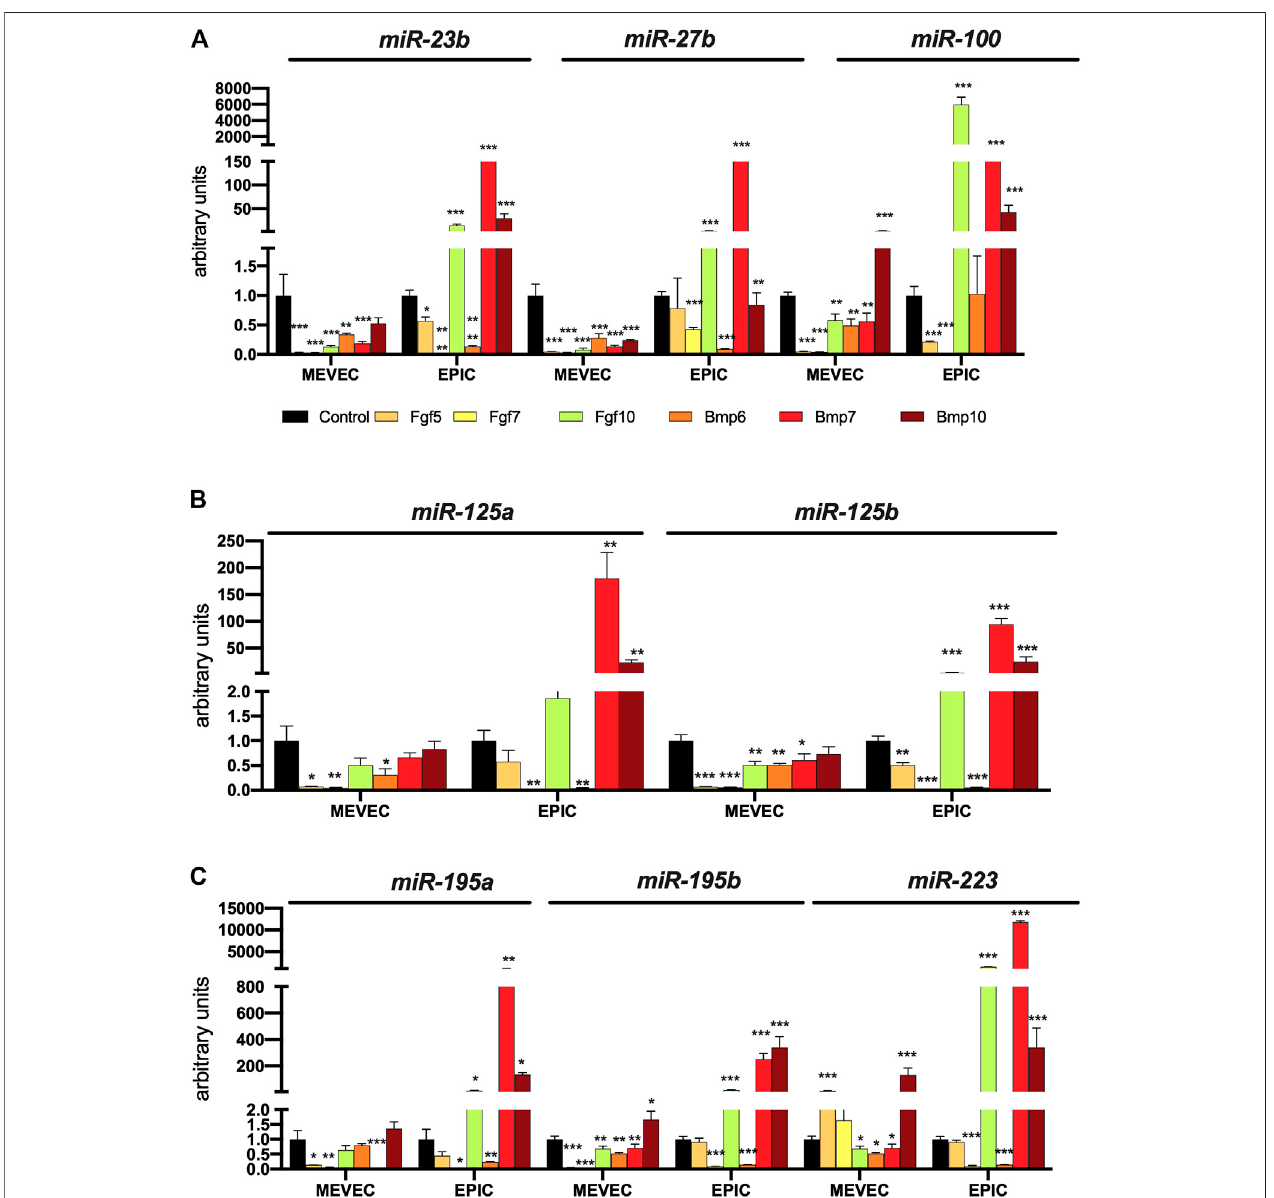
FIGURE10| Panel (A) RT-qPCRanalysesofmiR-23b, miR-27band miR-100expression after control, Bmp6,Bmp7,Bmp10, Fgf5, Fgf7and Fgf10treatments in MEVEC (endocardial) and EPIC (epicardial) cell lines, respectively. Panel (B) RT-qPCR analyses of miR-125a, miR-125b and miR-146b expression after control, Bmp6, Bmp7, Bmp10, Fgf5, Fgf7 and Fgf10 treatments in MEVEC (endocardial) and EPIC (epicardial) cell lines, respectively. Panel (C) RT-qPCR analyses of miR-195a, miR- 195b and miR-223 expression after control, Bmp6, Bmp7, Bmp10, Fgf5, Fgf7 and Fgf10 treatments in MEVEC (endocardial) and EPIC (epicardial) cell lines, respectively. * p < 0.05, ** p < 0.01, *** p < 0.001, **** p <